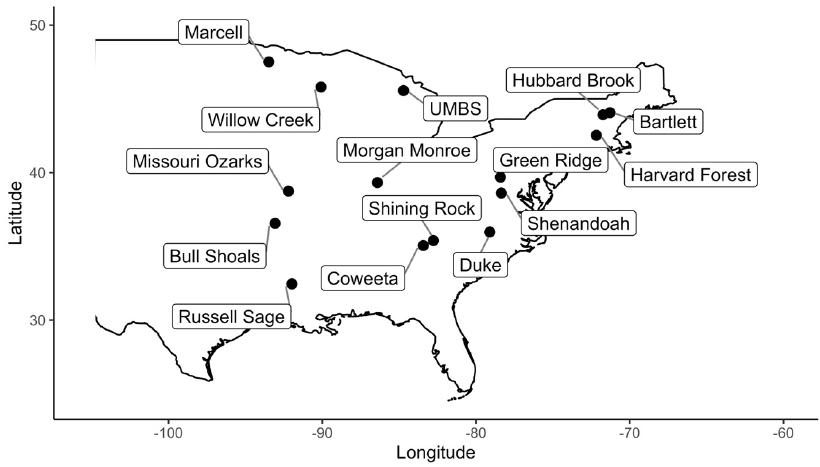
Figure 1. Locations for the selected sites. Map created using the ggmap package [19] in R [20]. Table 1. Characteristics of the chosen deciduous broadleaf sites. Climate data are from WorldClim [21] and elevation data are from the PhenoCam Network [22]. Sites are ordered based off of the number of days that had >10 observations within the year.